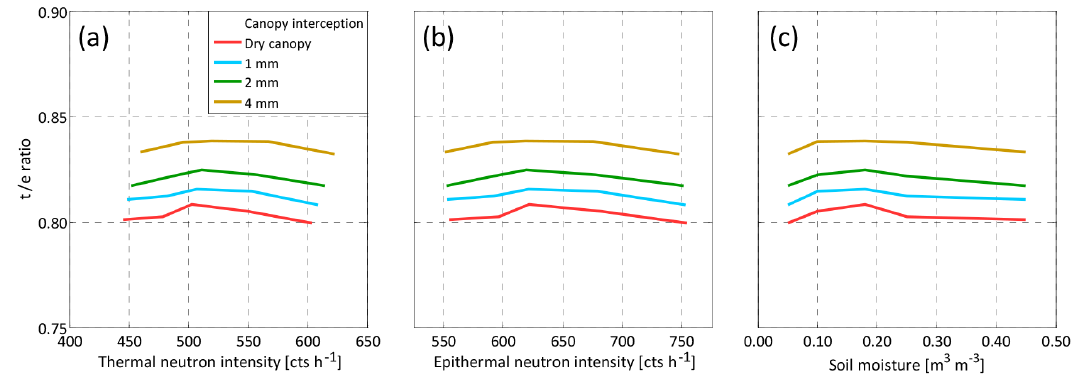
Figure 7. Modeled ground-level thermal-to-epithermal neutron intensity ratios using the model tree trunk, foliage, air for a dry forest canopy and canopy interception of 1, 2 and 4mm plotted against modeled (a) ground-level thermal neutron intensity, (b) ground-level epithermal neutron intensity and (c) volumetric soil